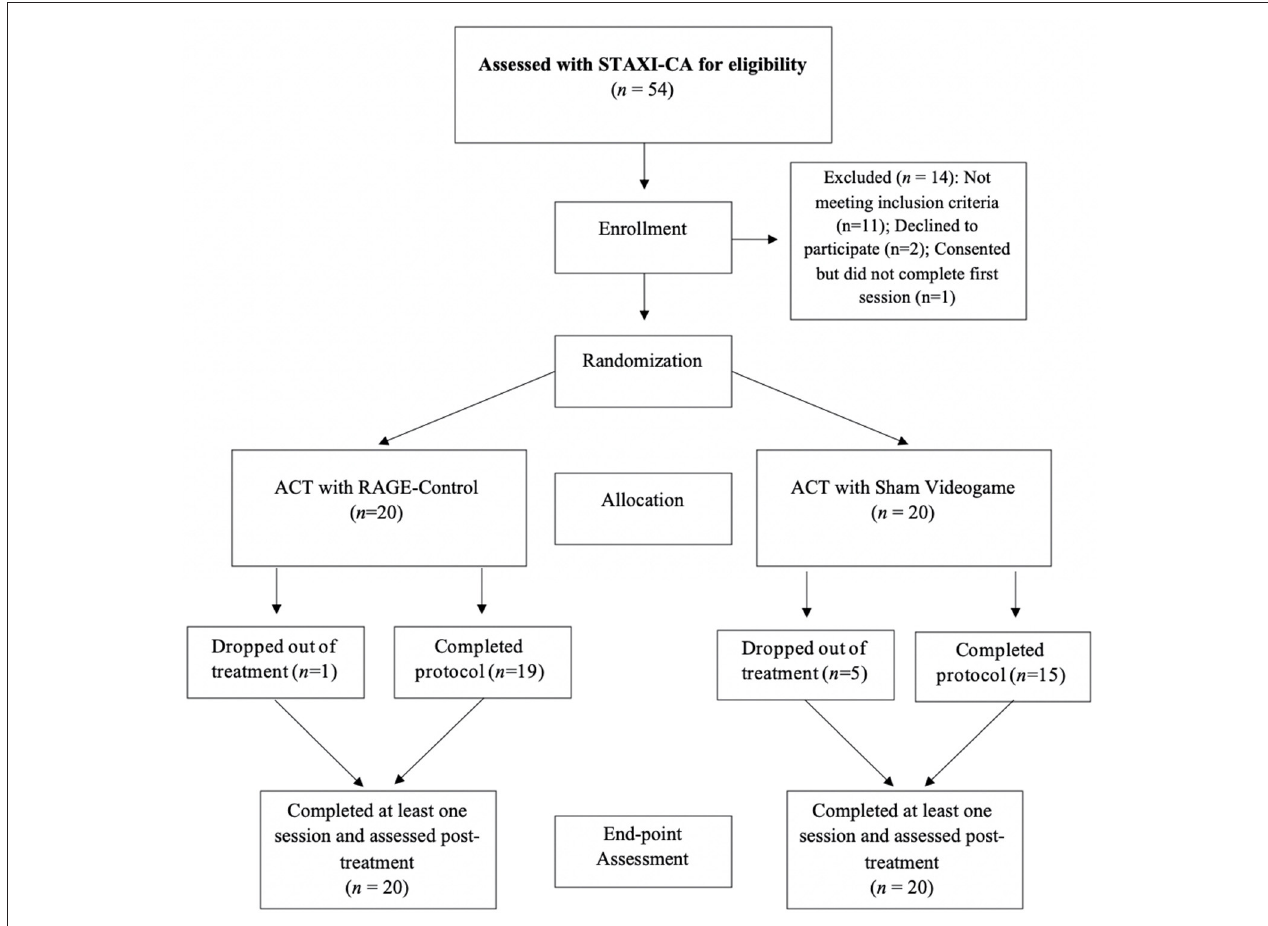
FIGURE 1 | Participant recruitment and study